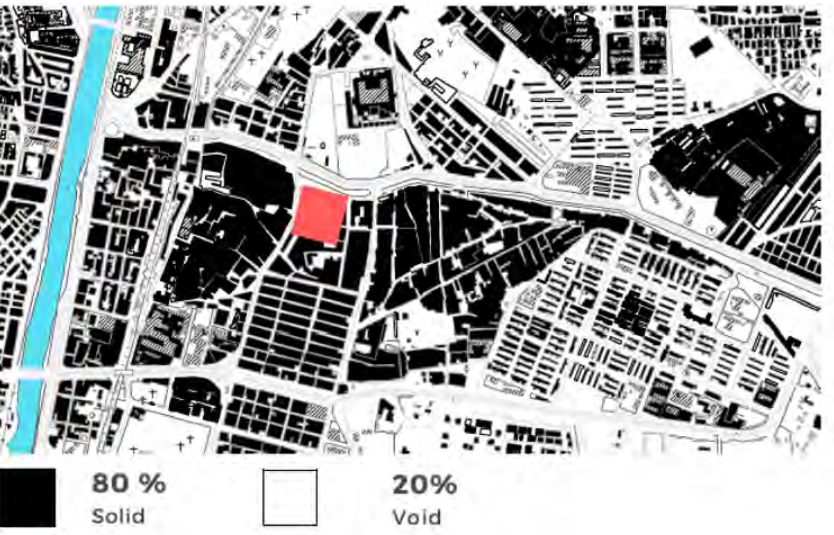
Figure 6. Solid and Void (Students research)